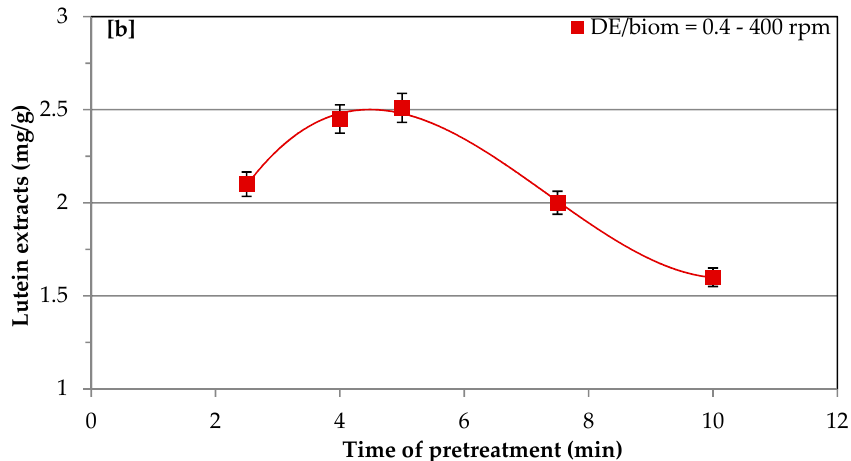
Figure 1. Role of different pretreatment conditions on extraction efficiency of lutein. ( a ) Effect of DE/biomass mixing ratio and rotation speed; ( b ) effect of pretreatment time at 400 rpm with a 0.4 DE/biomass ratio.